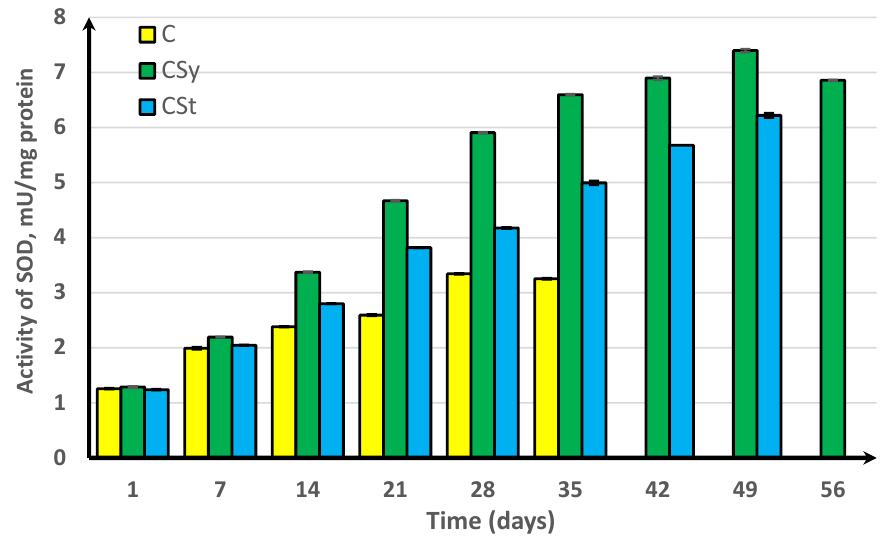
Figure 1. Superoxide dismutase (SOD) activities in workers’ hemolymph along with the aging pro- cesses, after using two methods of supplementation with hemp extract. C, control (pure sugar syrup); CSy, hemp extract in syrup; CSt, hemp extract on strips (two-way ANOVA; days of supplementation: F (5,1078) = 17,089, p = 0.0000, se ± 1.26111 (1st day), se ± 2.07672 (7th day), se ± 2.85162 (14th day), se ± 3.69264 (21st day), se ± 4.47489 (28th day), se ± 4.94804 (35th day), se ± 6.89712 (42nd day), se ± 6.80810 (59th day), and se ± 6.85724 (56th day); supplementation method: se ± 0.00767 (C), se ± 0.00627 (CSy), and se ± 0.00710 (CSt); supplementation method × days of supplementation: F (11,1078) = 1205.8, p = 0.000, and se ± 0.01880). The chart shows statistical averages. The standard deviations for the means in this plot ranged from 0.04136 to 0.30656.